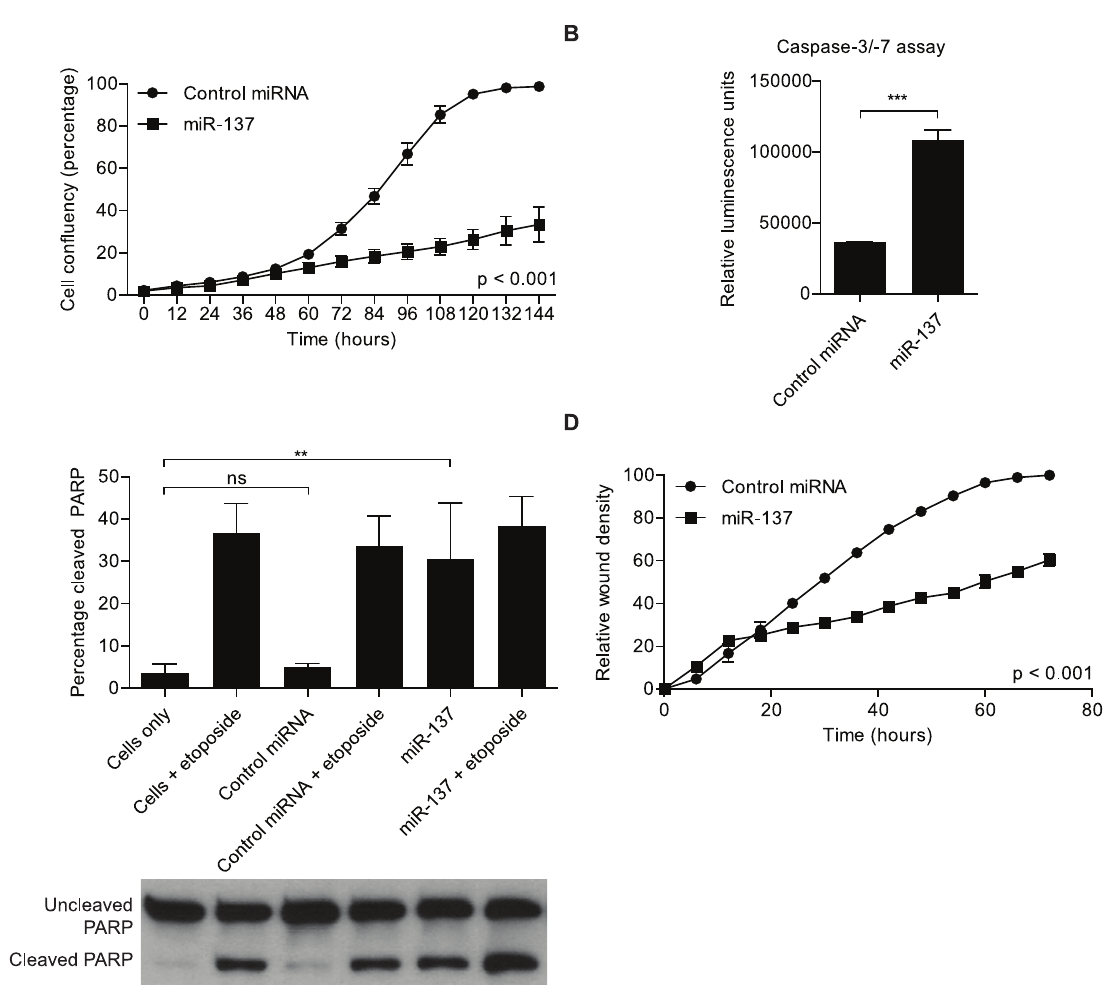
Figure 1. Impact of miR-137 mimics transfection on cancer relevant processes. A ) miR-137 transfection into U251 glioblastoma cells inhibits cell proliferation (p , 0.001, multiple comparison tests between groups). U251 cells were transfected with miR-137 or control miRNA and plated at a low density (500 cells per well). Cell proliferation was monitored using the Essen Bioscience IncuCyte automated microscope system and read out as percentage confluence. The experiment was monitored over a course of 6 days. The data was analyzed using analysis of variance, and the data is presented as the mean 6 standard deviation. B ) miR-137 transfection into U251 glioblastoma results in increased apoptosis, measured by caspase-3/-7 luminescent assay. Caspase-3/-7 activity, an indicator of apoptosis induction, increased after miR-137 transfection, as compared to the control miRNA transfection. Data was analyzed with Student’s t -test and is presented as the mean 6 standard deviation. *** indicates p # 0.001. C ) miR-137 transfection into U251 glioblastoma cells results in increased apoptosis, measured by Western blot of poly(ADP) ribose polymerase (PARP) cleavage. PARP cleavage, an end event of apoptosis, increased after miR-137 transfection, as compared to the control miRNA transfection. Etoposide (25 m M) was used as an inducer of apoptosis. Data was analyzed with Student’s t -test and is presented as the mean 6 standard deviation. ** indicates p # 0.01. a -tubulin was included as an endogenous loading control. D ) miR-137 transfection into glioblastoma cells results in decreased ability to migration (p , 0.001, multiple comparison tests between groups). U251 glioblastoma cells were transfected with miR-137 or control miRNA. An in vitro scratch assay was used to measure the ability for cell migration. The assay was monitored using Essen Bioscience IncuCyte automated microscope system. The data was analyzed using analysis of variance, and the data is presented as the mean 6 standard deviation. MiRanda to evaluate the number of genes containing miR-137 predicted sites in each set. Out of 647 evaluated genes, 312 (48%) were predicted by at least one tool – Figure 2B and D , Table S1 . TargetScan and MiRanda present differences in predictions while Pictar essentially recognizes a subset of TargetScan predictions - Figure 2D , Table S1 . To determine the significance of our results, we performed a hypergeometric test using the results of each individual prediction tool. These tests produced highly significant results in all cases - Figure 2C . Overall, the results suggest that the RIPSeq strategy functions slightly better than straight RNASeq to identify miRNA targets.